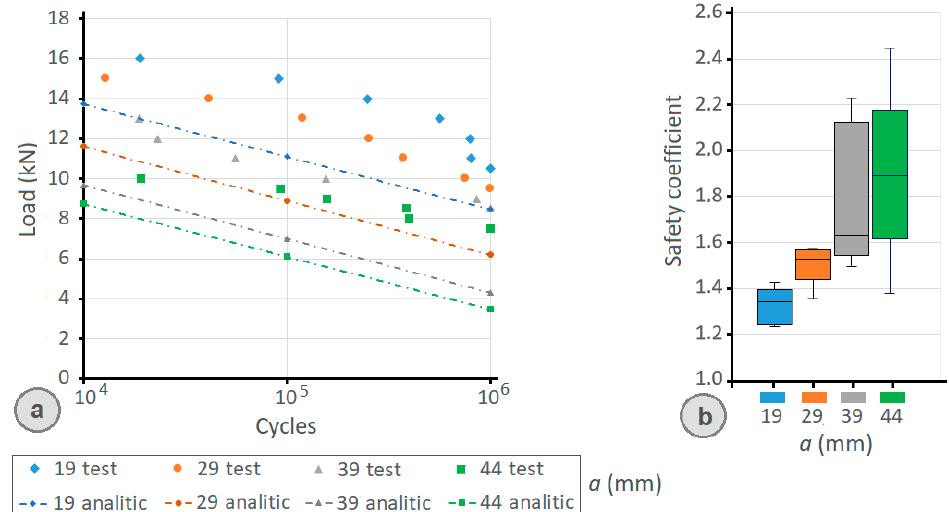
Figure 18. ( a ) Comparison between the results obtained with the analytical model and the results of the experimental tests; ( b ) box plot of the safety coefficient between the theoretical values according to the analytical model and the values according to the test.